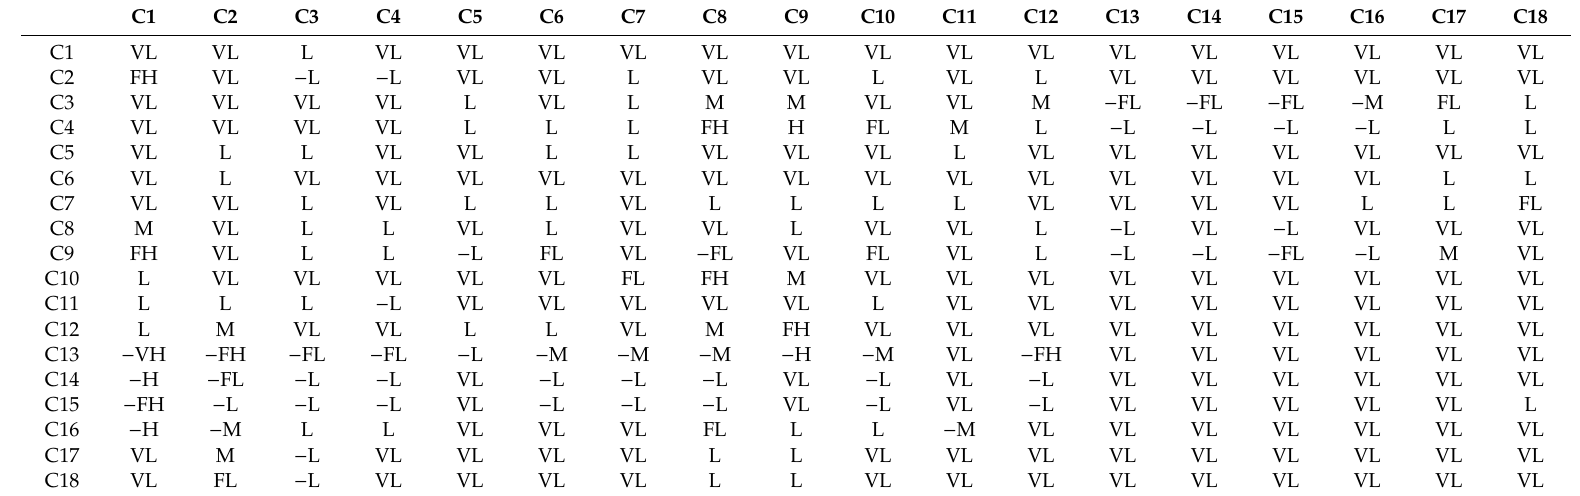
Table 3. One expert’s advice on the strength of these